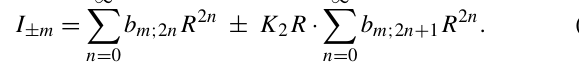
Figure 2. SSB combination I + vs. w = ( ω 0 δ/ω r ) 1 and different degrees of approximation. The numbers in the legend are the maximum powers of w considered. The curves correspond- ing to successive orders are alternatively coming closer or farther away from the second-order approximation (parabola) because of alternating signs of terms of different powers. In any case the con- vergence is very fast up to w =